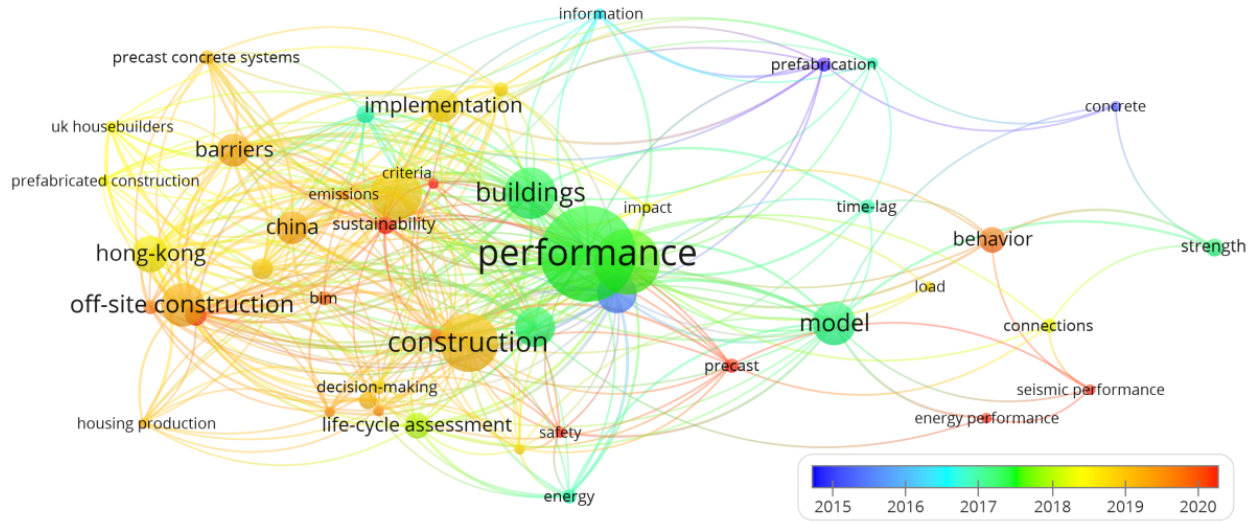
Figure 1. Overlay visualization diagram related to the economic management policy of prefabricated buildings.